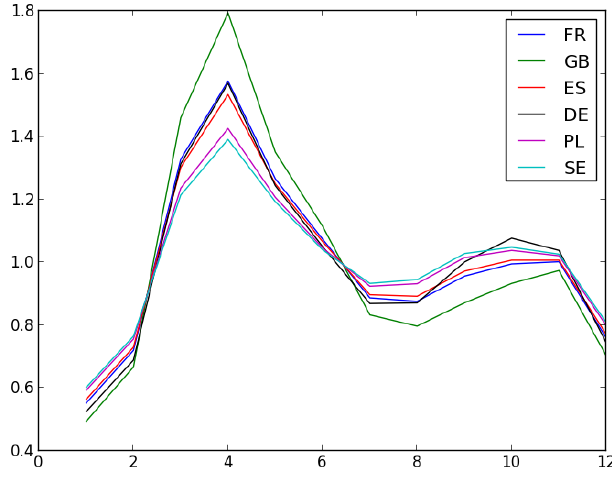
Figure 7. Seasonal factors used in CHIMERE to compute the evo- lution of NH 3 emissions for several countries. The factors originate from GENEMIS (Ebel et al.,